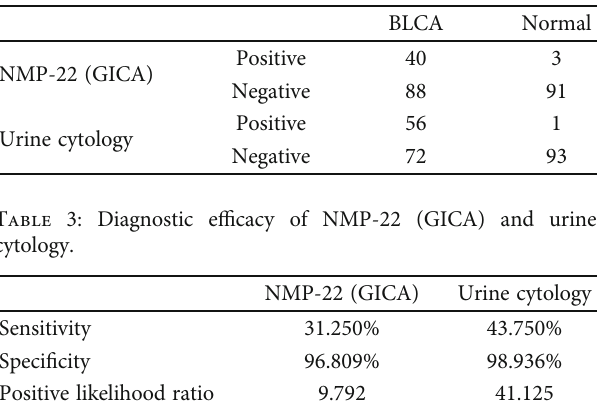
Figure 4: Diagnostic ability of exosomal telomerase RNA component (TERC) and nuclear matrix protein- (NMP-) 22 for bladder urothelial carcinoma (BLCA). (a – c) Receiver operating characteristic curve analysis of exosomal TERC and NMP-22 (ELISA) and the combination of these indicators revealed area under the curve values of 0.836, 0.696, and 0.861. Table 2: Statistics of NMP-22 (GICA) and urine cytology in BLCA patients and normal individuals.